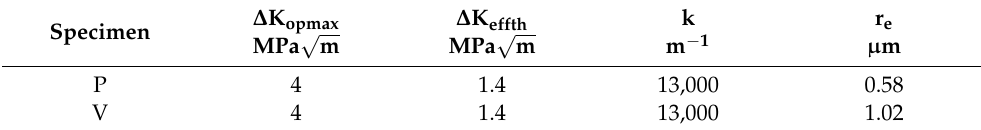
Table 4. Parameter values used to calculate M.